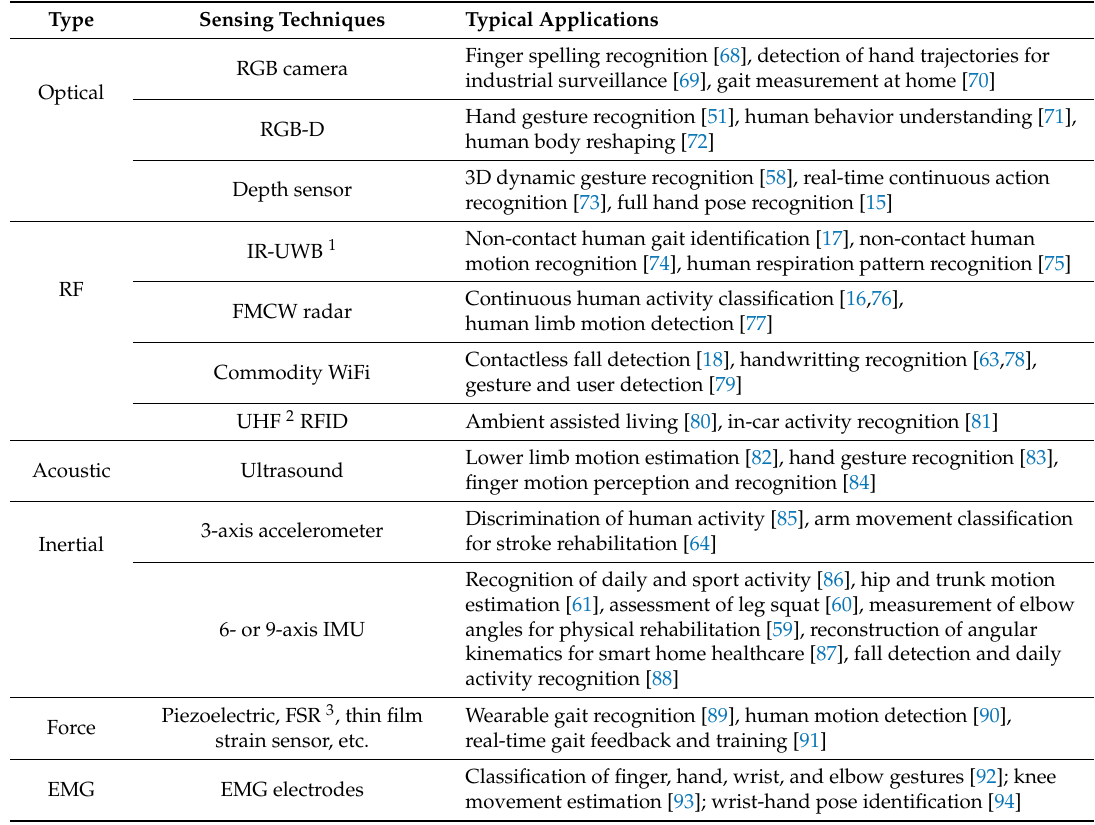
Table 2. Sensing techniques with typical